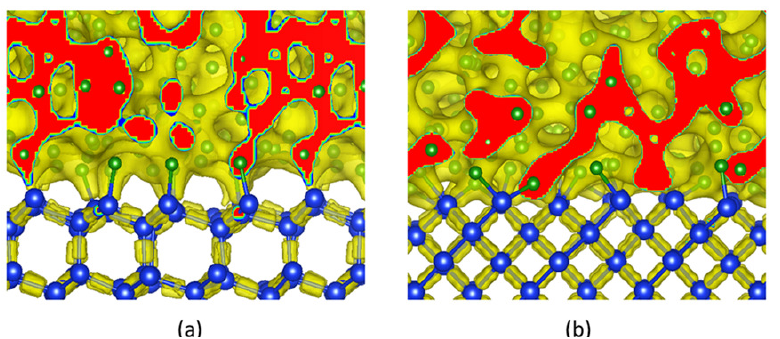
Figure 9. Electron density distribution (iso-surfaces ρ 0 ( r ) = 0.075 e/Å 3 ) and charges at the atomic sites at the ( a ) Si{0 0 1}/a-B and ( b ) Si{1 1 1}/a-B interfaces, respectively. The blue squares represent Si sites, the blue spheres the B sites and the filled black spheres for the averaged charge values. The broken red lines represents the centre of surficial Si and the broken green lines for the centres of interfacial a-B.